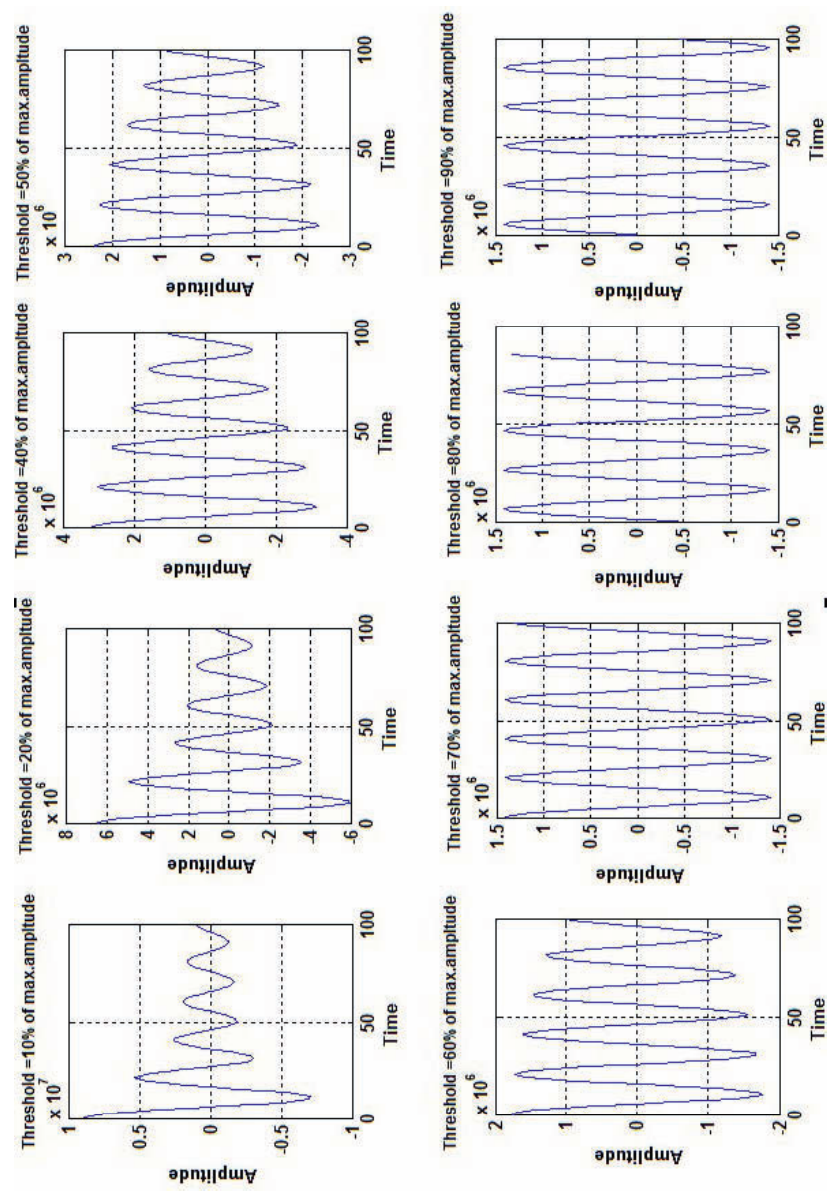
Figure 10. Denoised